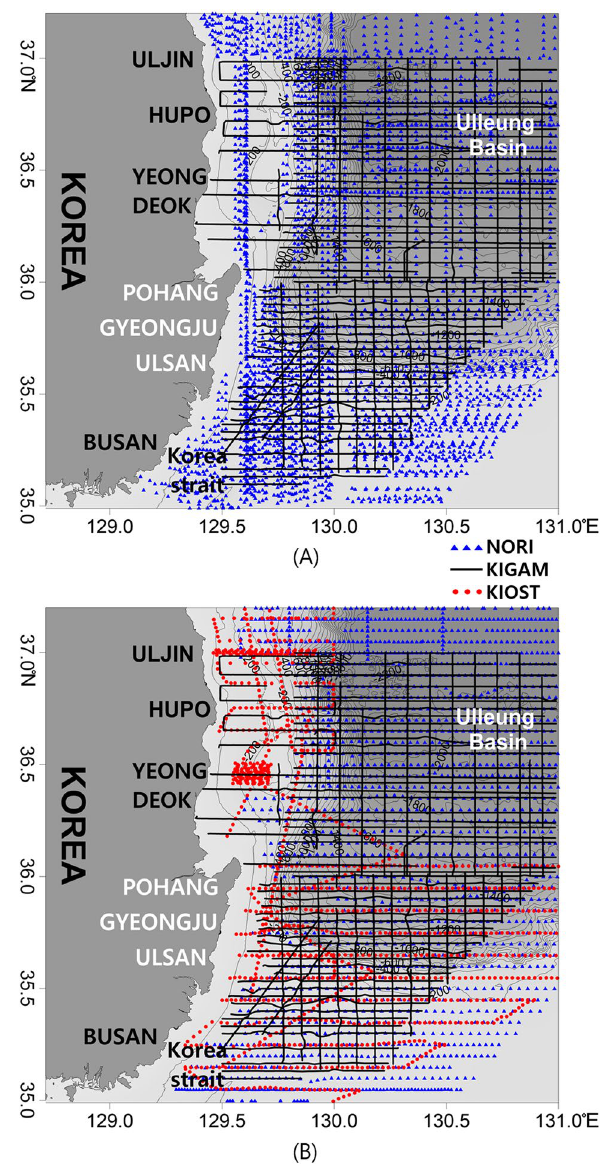
Figure 3. ( A ) Survey tracks for gravity data and ( B ) survey tracks for magnetic data. NORI – National Oceanographic Research Institute of Korea; KIGAM – Korea Institute of Geoscience and Mineral Resources; KIOST – Korea Institute of Ocean Science and Technology. This figure was generated using the Surfer software (https:// www. golde nsoft ware.